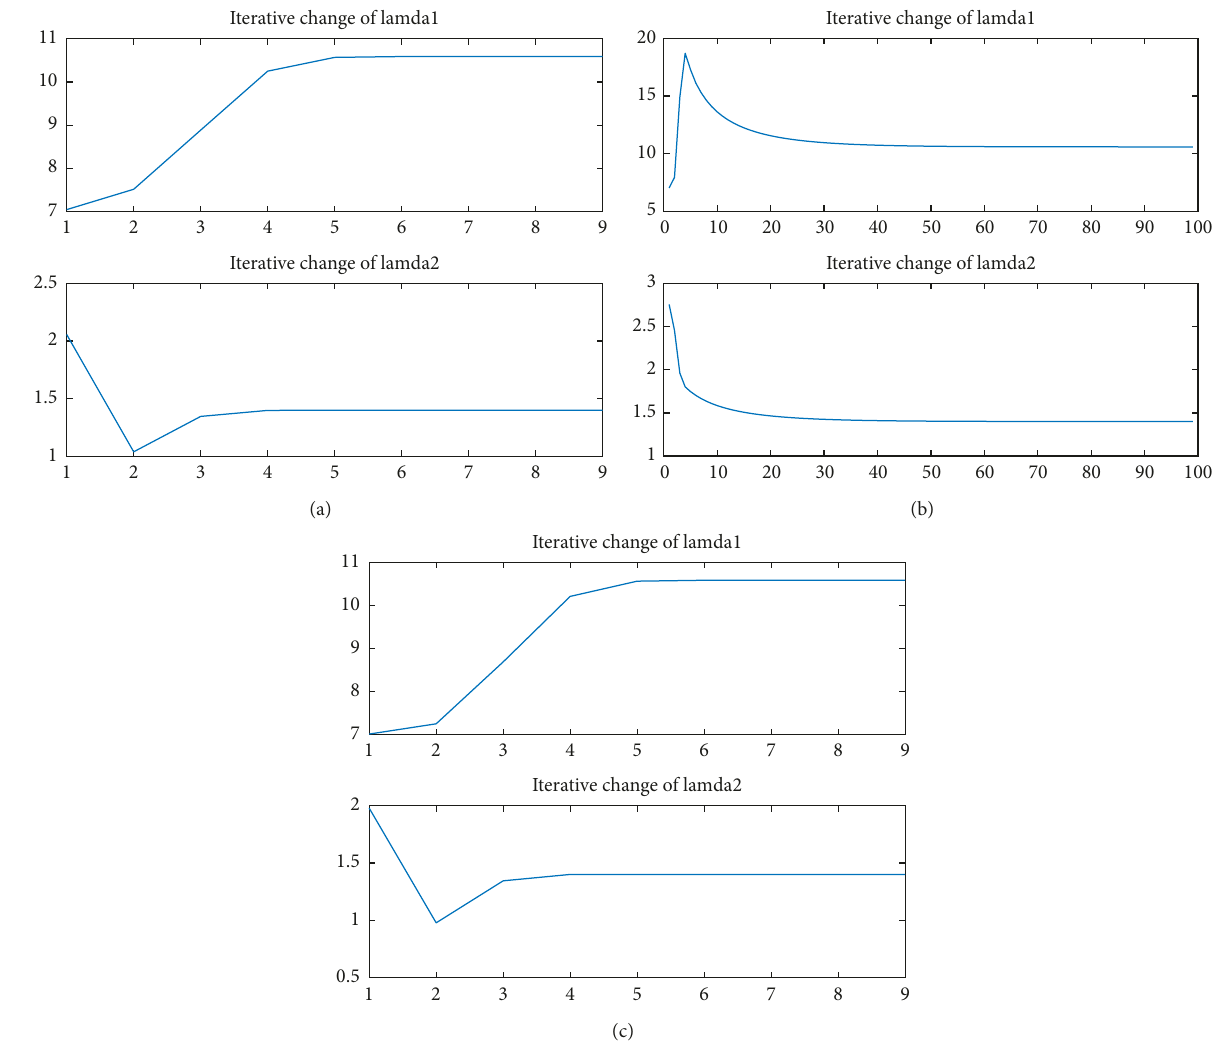
GP . (b) VP KAU . (c) VP RJF .